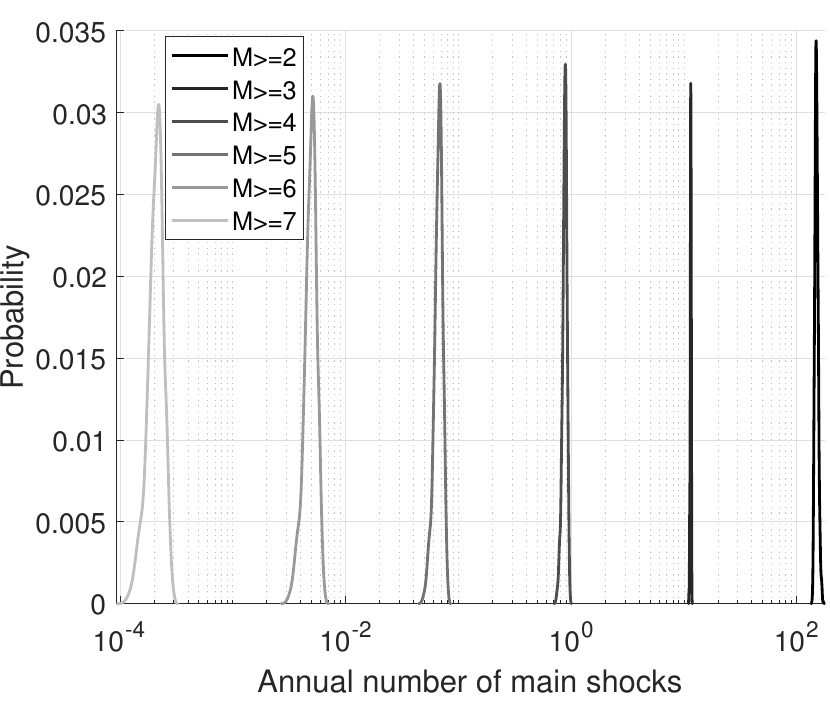
Figure 8. Probability density function of frequency of main shocks for different magnitudes according to the stochastic FMD of main shocks visible in Figure